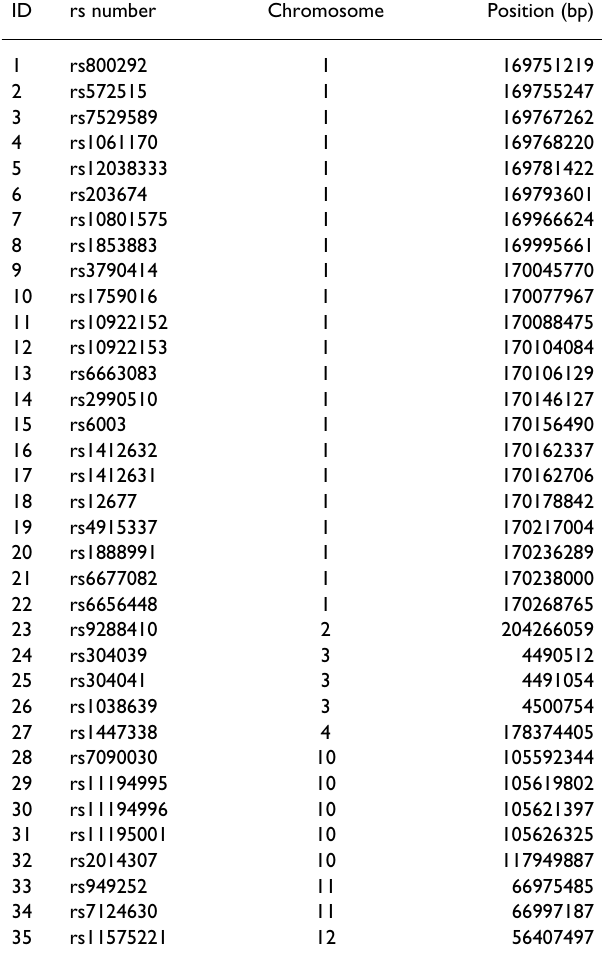
Table 2: Legend of Figure